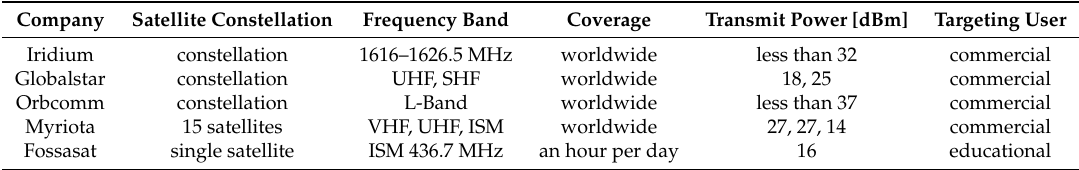
Table 2. Comparison of different practical Internet of Things (IoT)-over-Satellite systems.